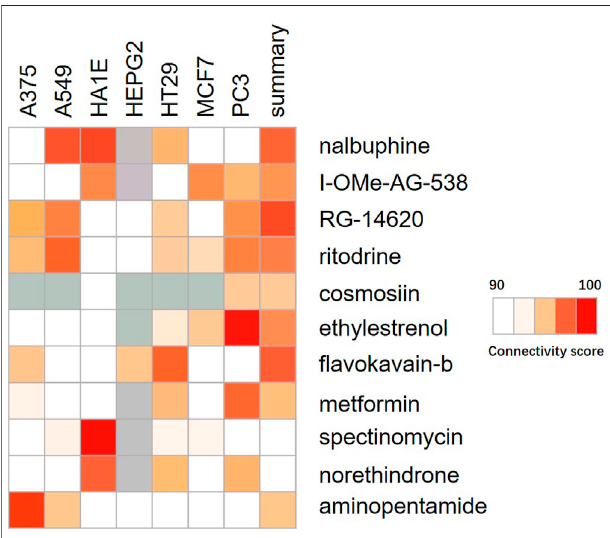
FIGURE 8 | Heat map of compounds interacting with ACSL4. The connectivity score was calculated using kolmogorov-Smirnov two-sided statistics implemented in